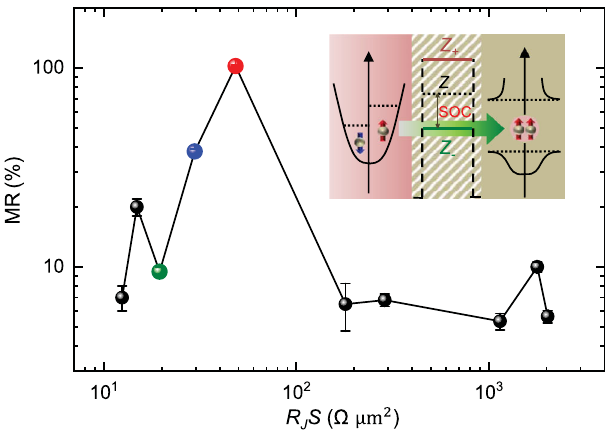
Fig. 5 The interface barrier dependence of MR at Fe 0.29 TaS 2 /SC interface. The MR ratio as a function of the interface resistance area product ( R J S) measured on various devices in the low voltage bias region.